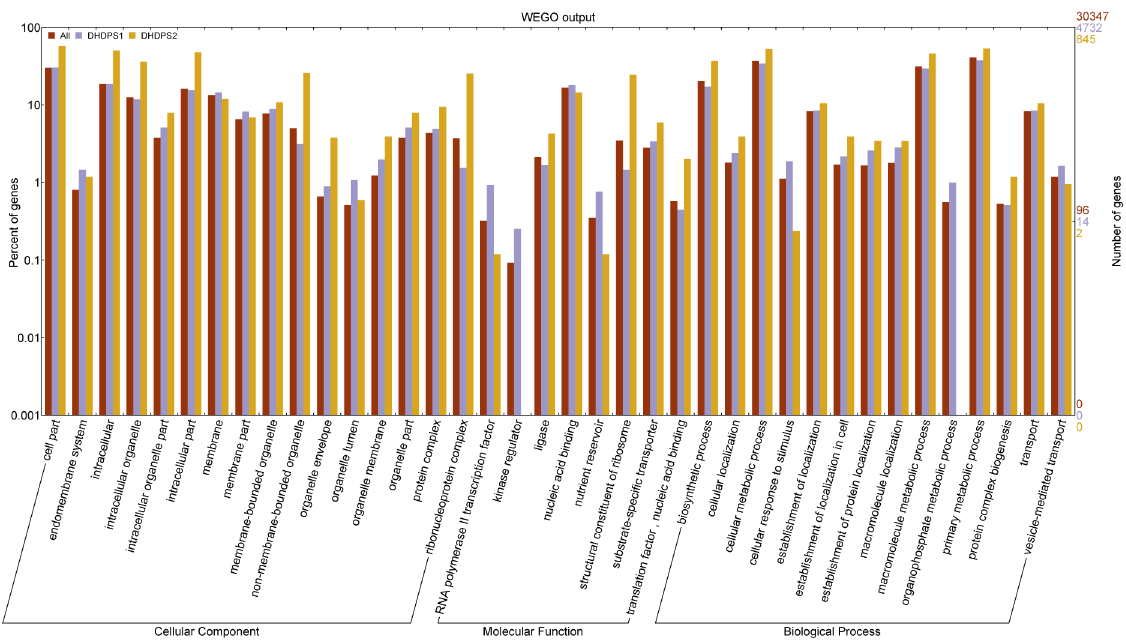
Fig 5. Gene Ontology (GO) functional enrichment analysis of DHDPS coexpressed genes. All represent all genes set (RefGen_v2 5b). DHDPS1 and DHDPS2 represent DHDPS1 and DHDPS2 coexpressed genes. GO categories among cell component, molecular function and biological process that show significant ( P < 0.05) enrichment than all genes